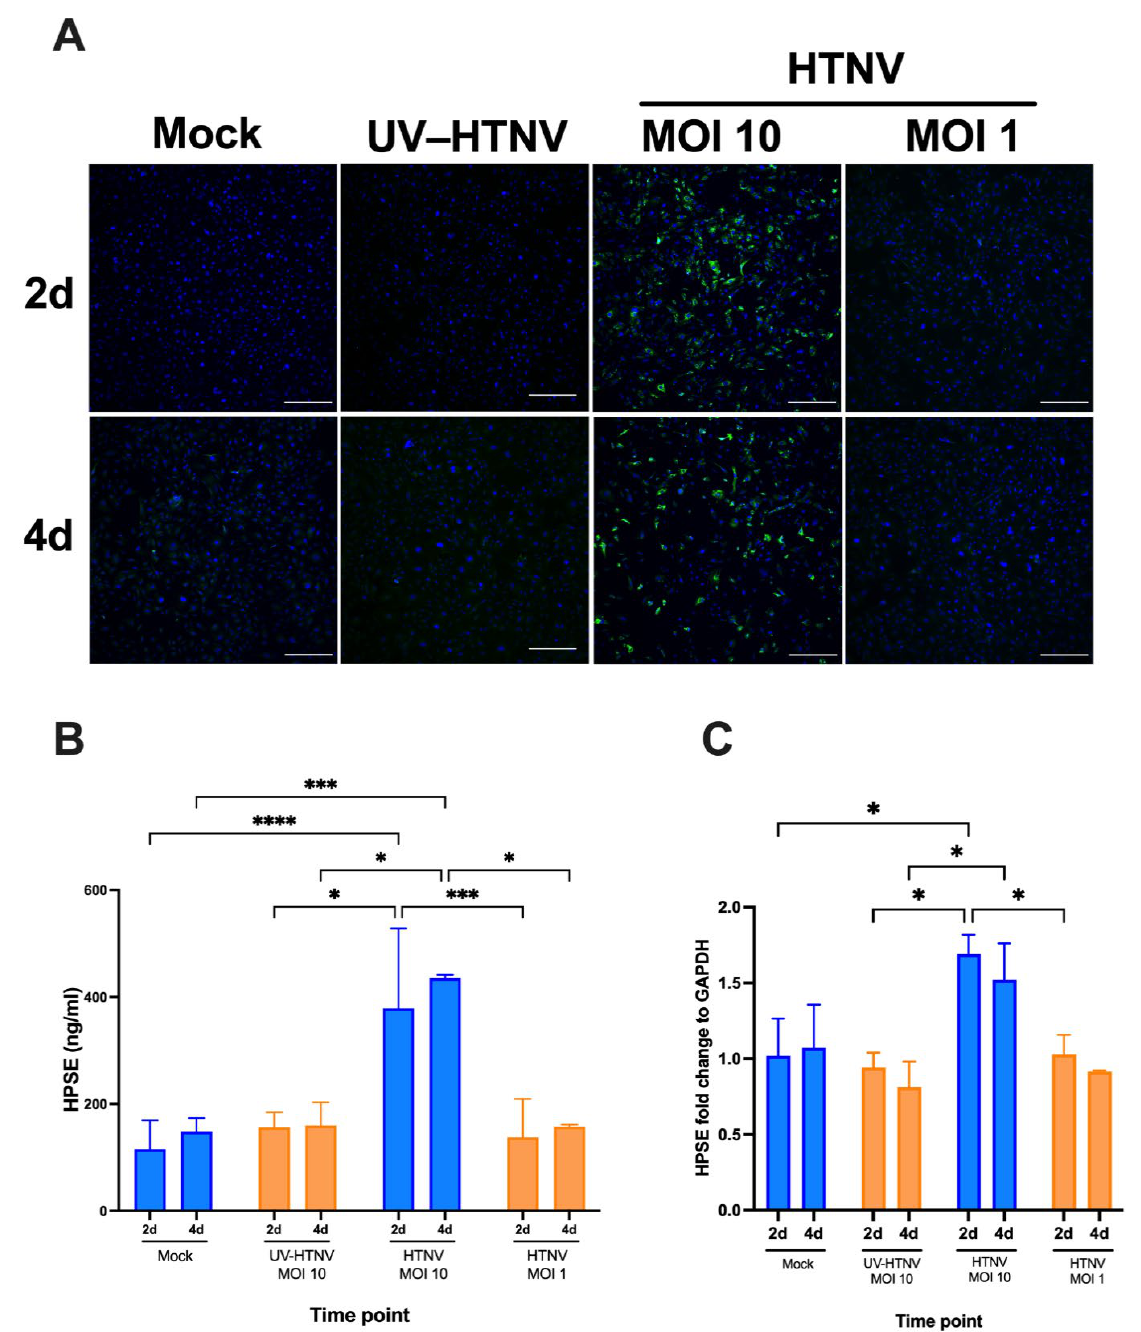
Figure 4. Increased HPSE concentration in HTNV–infected podocytes. Podocytes were infected with live HTNV (MOI 10 or 1), UV–inactivated HTNV (MOI 10) or remained uninfected (mock). Supernatants were collected and cells either fixed for immunofluorescence analysis or subjected to RNA extraction at 2 and 4 dpi. ( A ) Fixed and permeabilized podocytes were stained with rabbit serum against viral nucleocapsid N protein followed by AF488–conjugated secondary antibody (green) or Hoechst 33,420 to detect nuclei (blue). ( B ) HPSE levels measured from podocyte supernatants. ( C ) Isolated RNA was subjected to multiplex RT–qPCR with primers and probes detecting HPSE and GAPDH mRNA. The signal for HPSE mRNA was normalized based on GAPDH mRNA levels and were assessed with Tukey’s multiple comparisons test. ****, *** and * indicate p < 0.0001, p < 0.001 and p < 0.05,